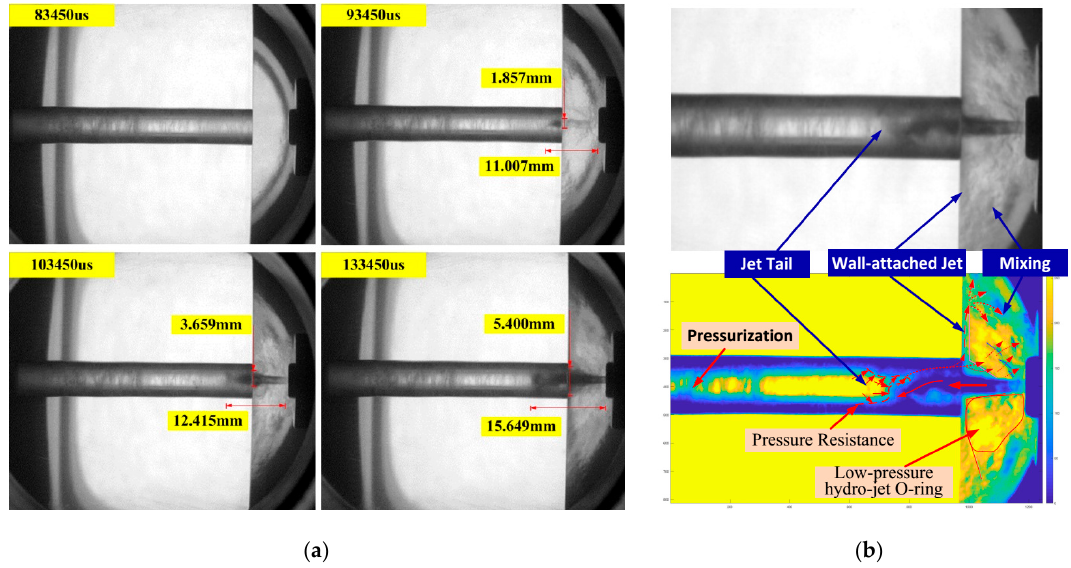
Figure 18. The High-speed photograph of SC-CO2 jet. ( a ) The development of a SC-CO 2 jet; ( b ) Instantaneous flow field.